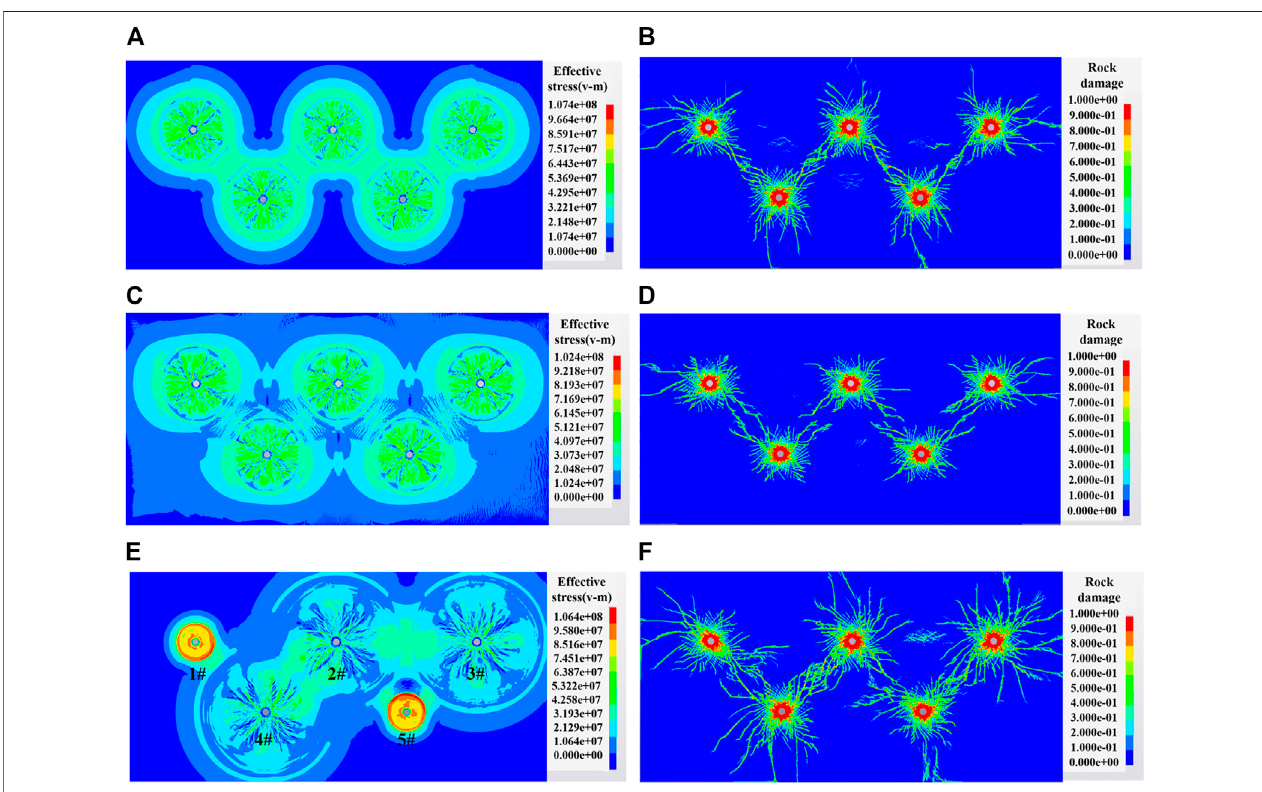
FIGURE7| Stressanddamagenephogramofrockblasting: (A) stresswaveexpansionnephogramofmodelA, (B) fi naldamagenephogramofmodelA, (C) stress waveexpansionnephogramofmodelB, (D) fi naldamagenephogramofmodelB, (E) stresswaveexpansionnephogramofmodelC,and (F) fi naldamagenephogramof model